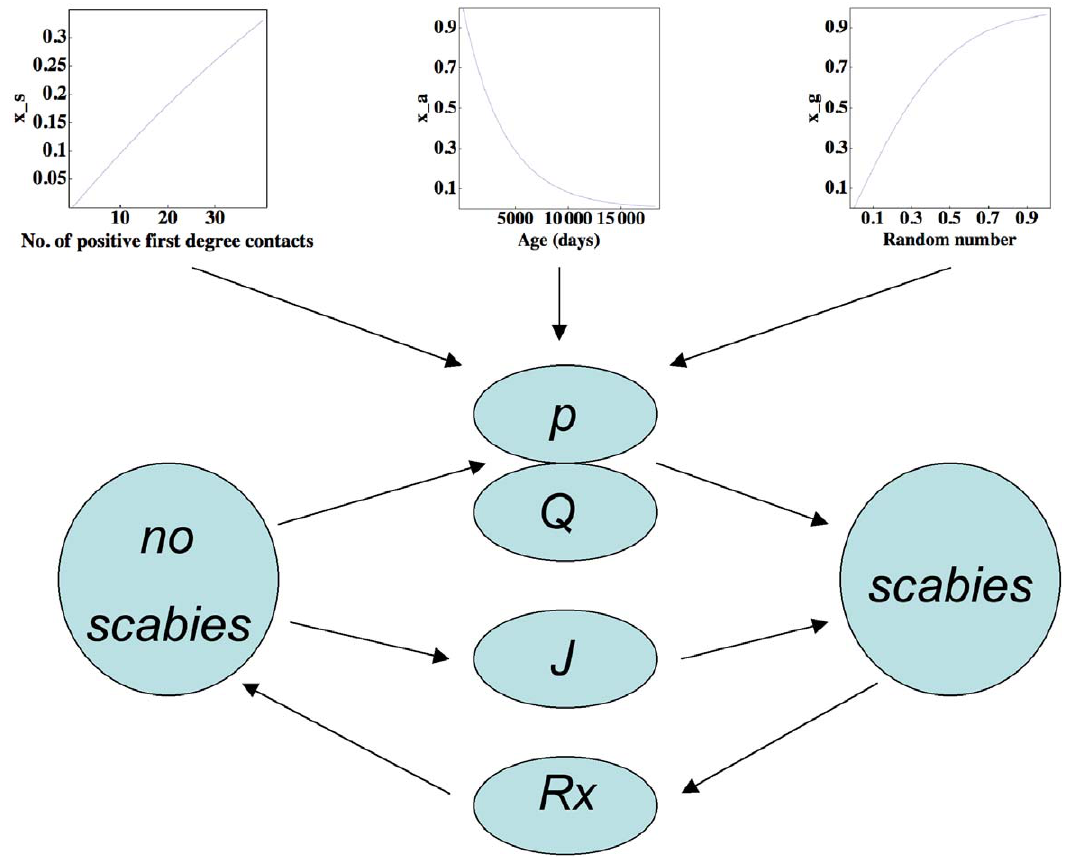
Figure 3. The updating rules. The decision algorithm determining whether a non-affected individual within the community acquires scabies or whether an affected person is treated is shown in schematic form. The probability of developing scabies depends on the number of first-degree contacts that are positive (governed by the relation shown at top left), the individuals’ age (top centre relation) and their genetic susceptibility (top right relation), in addition to Q , the community-wide acquisition probability, and J , the probability of acquiring scabies from person(s) external to the community. Treatment probabilities ( Rx ) are defined in terms of density and frequency.